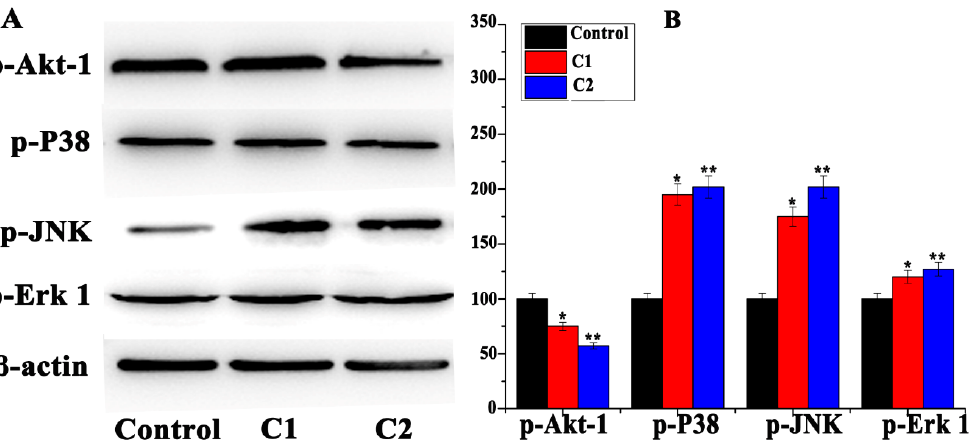
Figure 9. ( A ) Western blot analysis of Akt1/2, P38, JNKs, Erk-1/2 in A-549 cells treated with C1 (1.4 μ M) and C2 (1.4 μ M). ( B ) Percentage expression levels of Akt1/2, P38, JNKs, Erk-1/2 relative to their control value. Mean ± SD, n = 3, * p < 0.05, ** p <